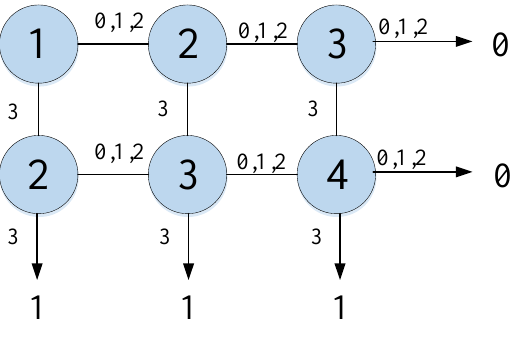
Figure 5. MDD for the cloud RAID 5 in the failed